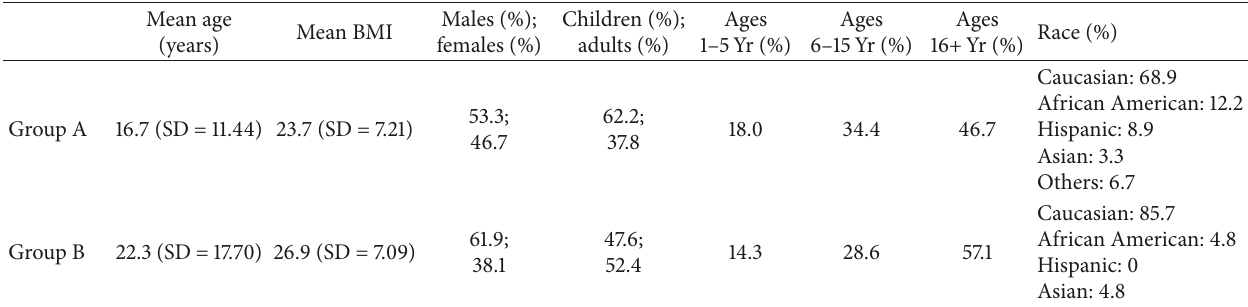
Table 1: Comparison of demographic data.